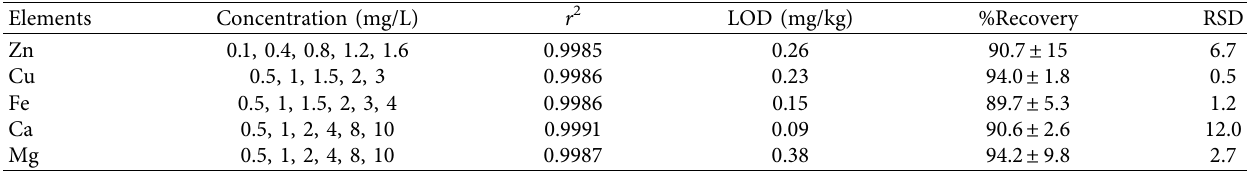
Table 6: Concentration of standard solutions, coefcient of determination ( r 2 ), limit of detection (LOD), recovery, and the associated relative standard deviation (RSD) values of the method used for the determination of metallic elements in the soil samples. Elements